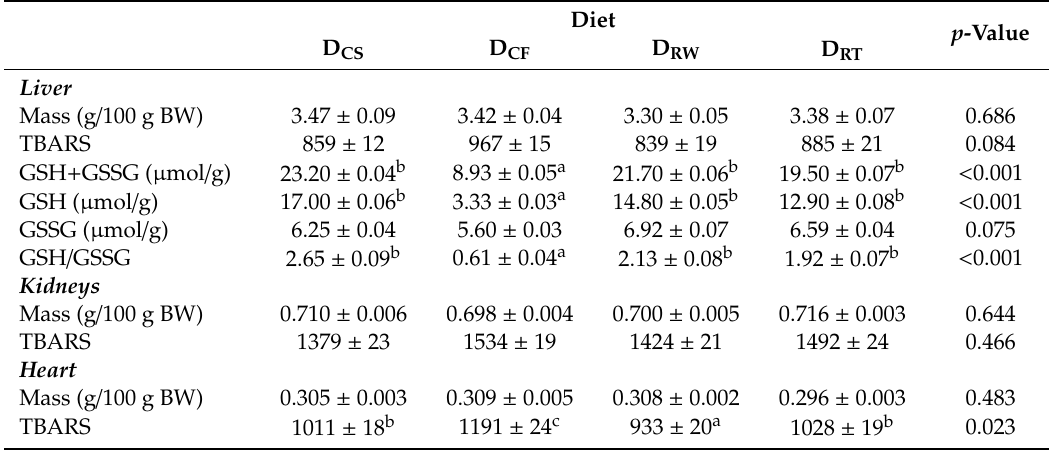
Table 7. Antioxidant status and TBARS levels of the liver, kidneys, and heart in rats fed experimental diets. Data are expressed as mean ± SEM, n =